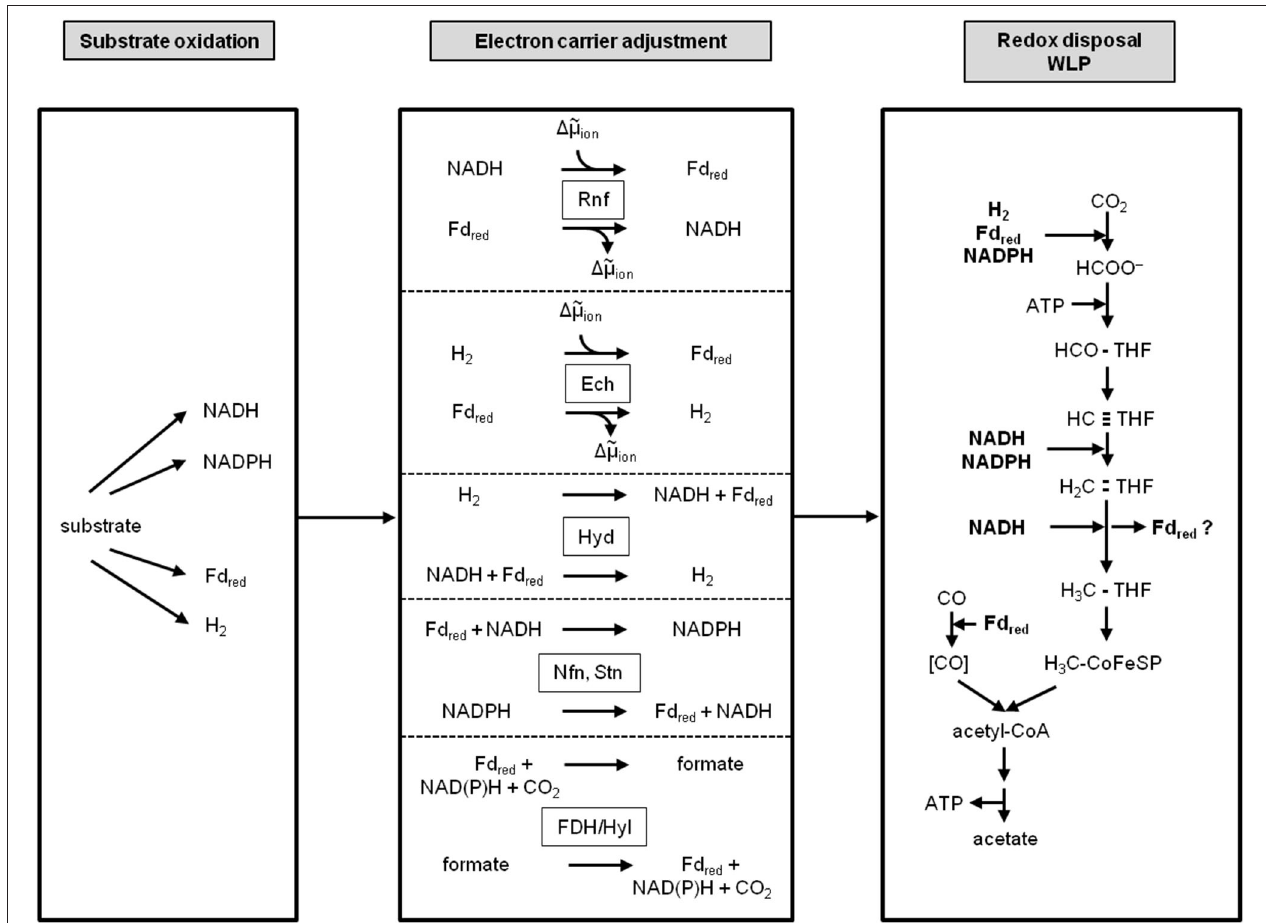
FIGURE 3 | Modularity of acetogenesis. Depending on the redox potential of the substrate, redox carriers with different redox potentials are reduced. The WLP requires species-specific, fixed sets of distinct electron carriers with different redox potentials. To switch electron carriers between the substrate oxidation module and the WLP, a third module that adjusts the electron carriers is required; it contains enzymes like Rnf, Ech, electron-bifurcating hydrogenase, Nfn/Stn or the electron-bifurcating hydrogenase/formate dehydrogenase complex. THF, tetrahydrofolic acid; Hyd, electron-bifurcating hydrogenase; FDH/Hyl, electron-bifurcating formate dehydrogenase; Nfn, electron-bifurcating, ferredoxin-dependent transhydrogenase; Stn, Sporomusa type